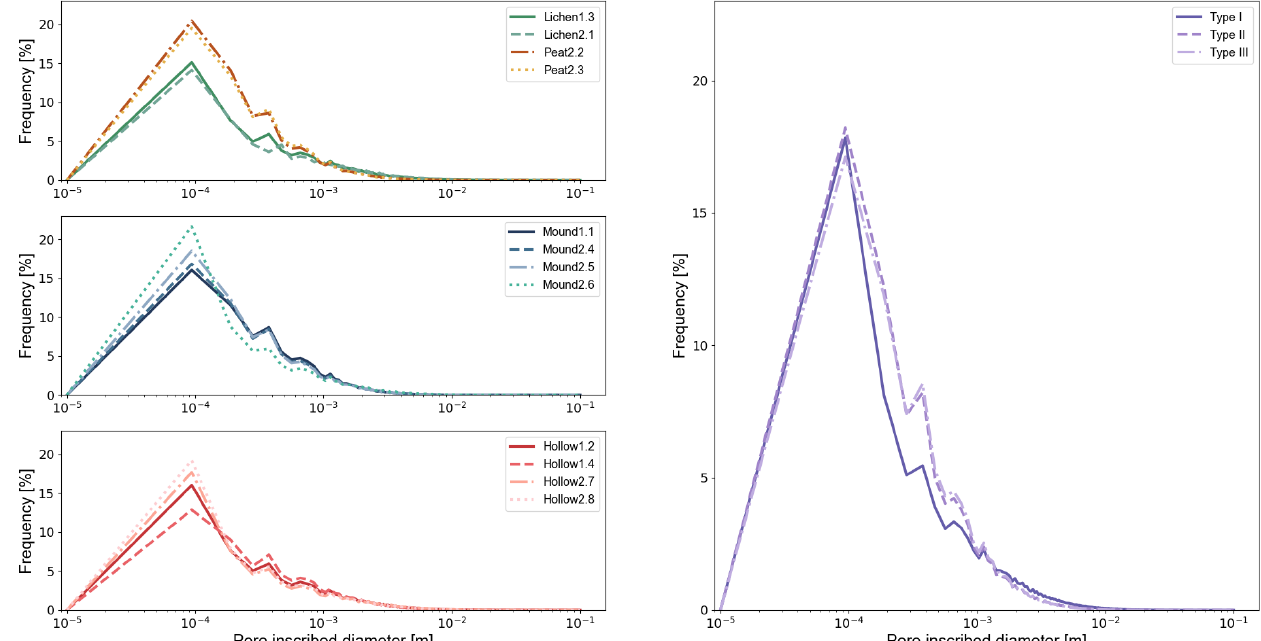
Figure 5. Inscribed pore size distribution by classified type using particles’ Feret diameter measurement. An averaged value is computed for each sample type, each color nuance representing each